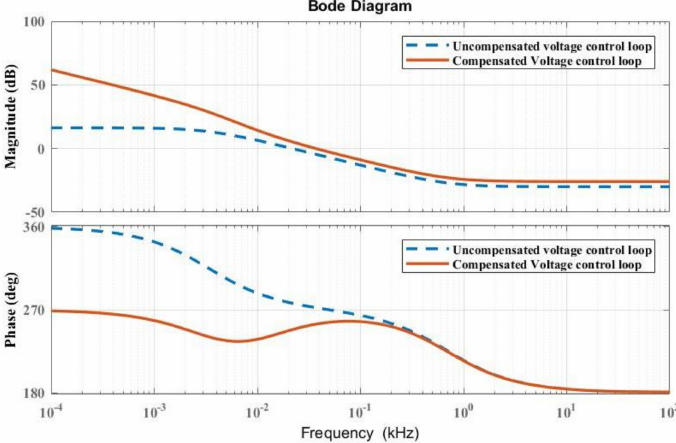
Figure 12. Bode plot for uncompensated and compensated voltage control loop of